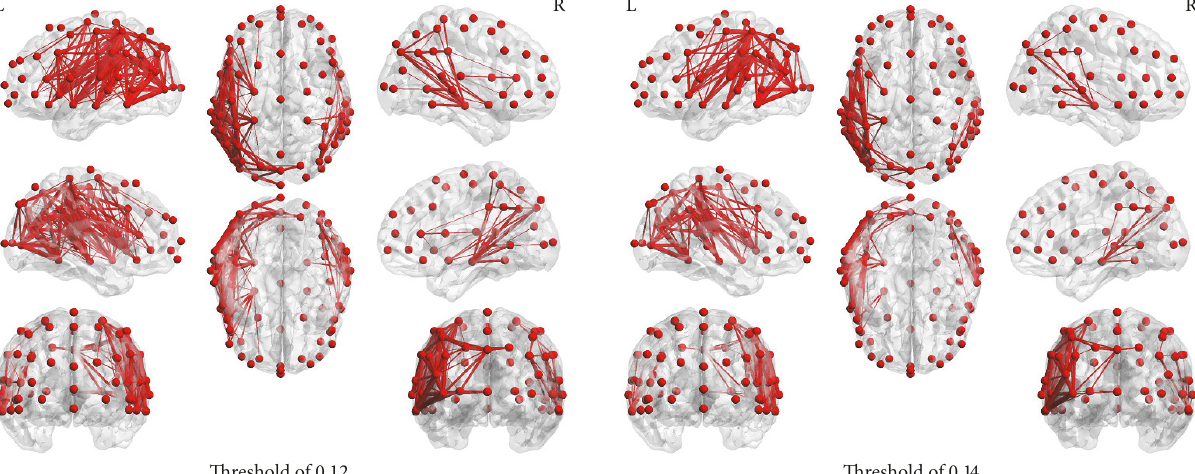
Figure 3: The results of the distribution which was the difference of the coherence in the theta band. Red nodes represent 72 electrodes, and the red lines between nodes show the difference in coherence at the threshold of 0.12 and 0.14. The thicker the red line is, the more the threshold is